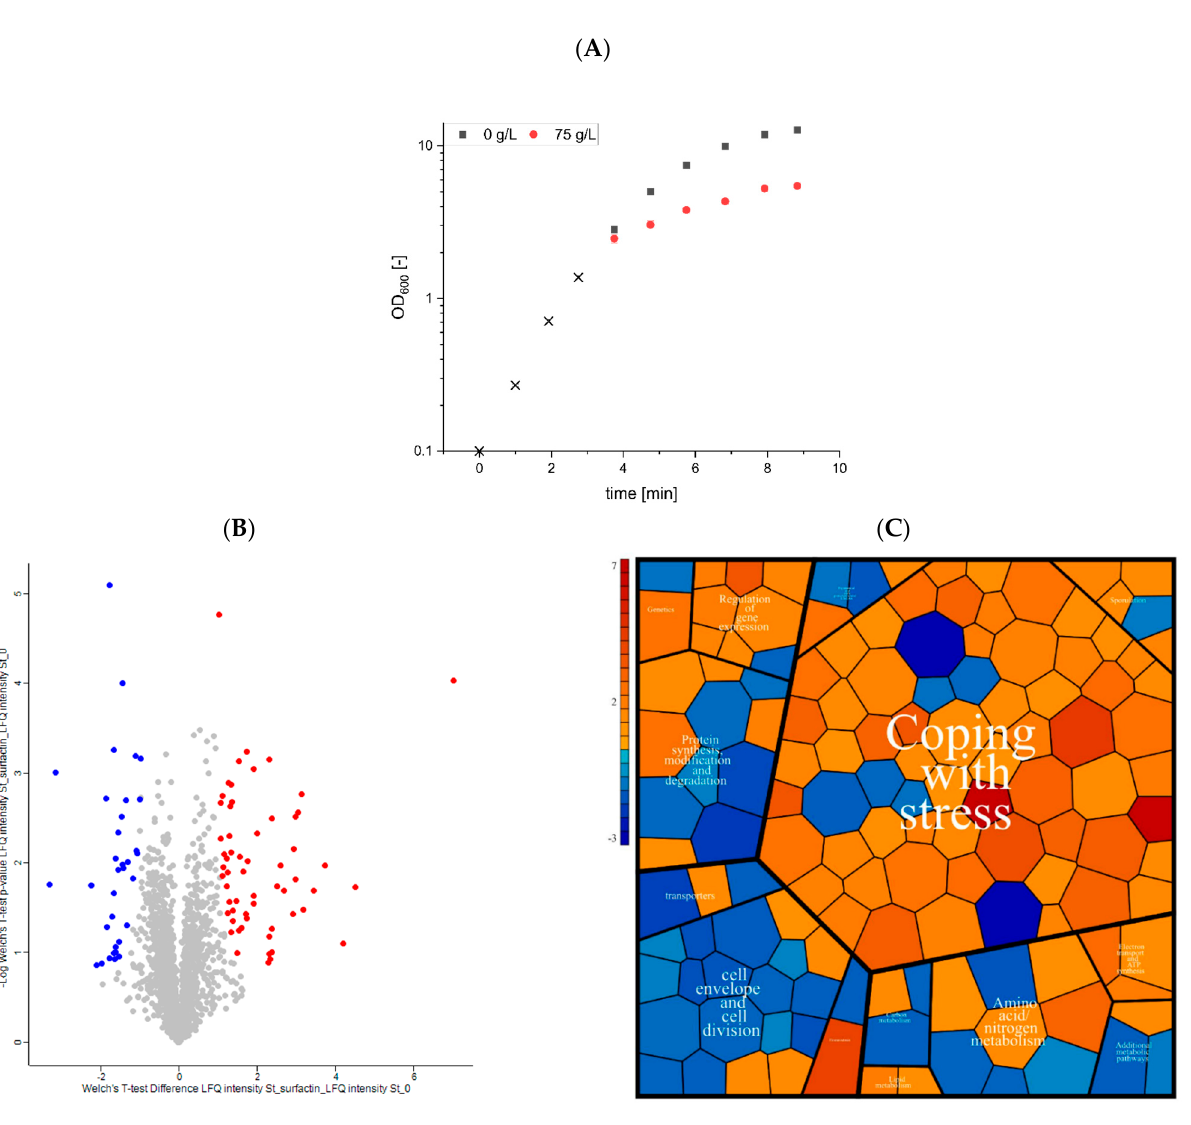
Figure 4. Identification and classification of proteins with altered abundance after surfactin treatment. ( A ) B. subtilis KM0 was cultivated in mineral salt medium (black crosses). An equal volume of the cell suspension was then mixed with either fresh mineral salt medium (black squares) or with surfactin solution (red dots). The cultivations and stress approaches were performed in biological